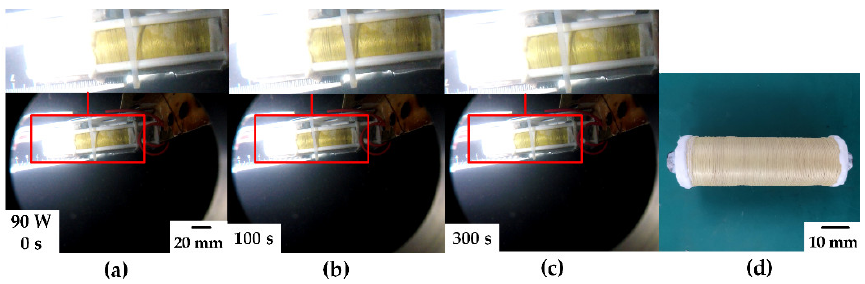
Figure 9. DDM test at 110 MPa hydrostatic pressure: ( a – c ) experimental process at 90 W and ( d ) prototype at 110 MPa hydrostatic pressure.